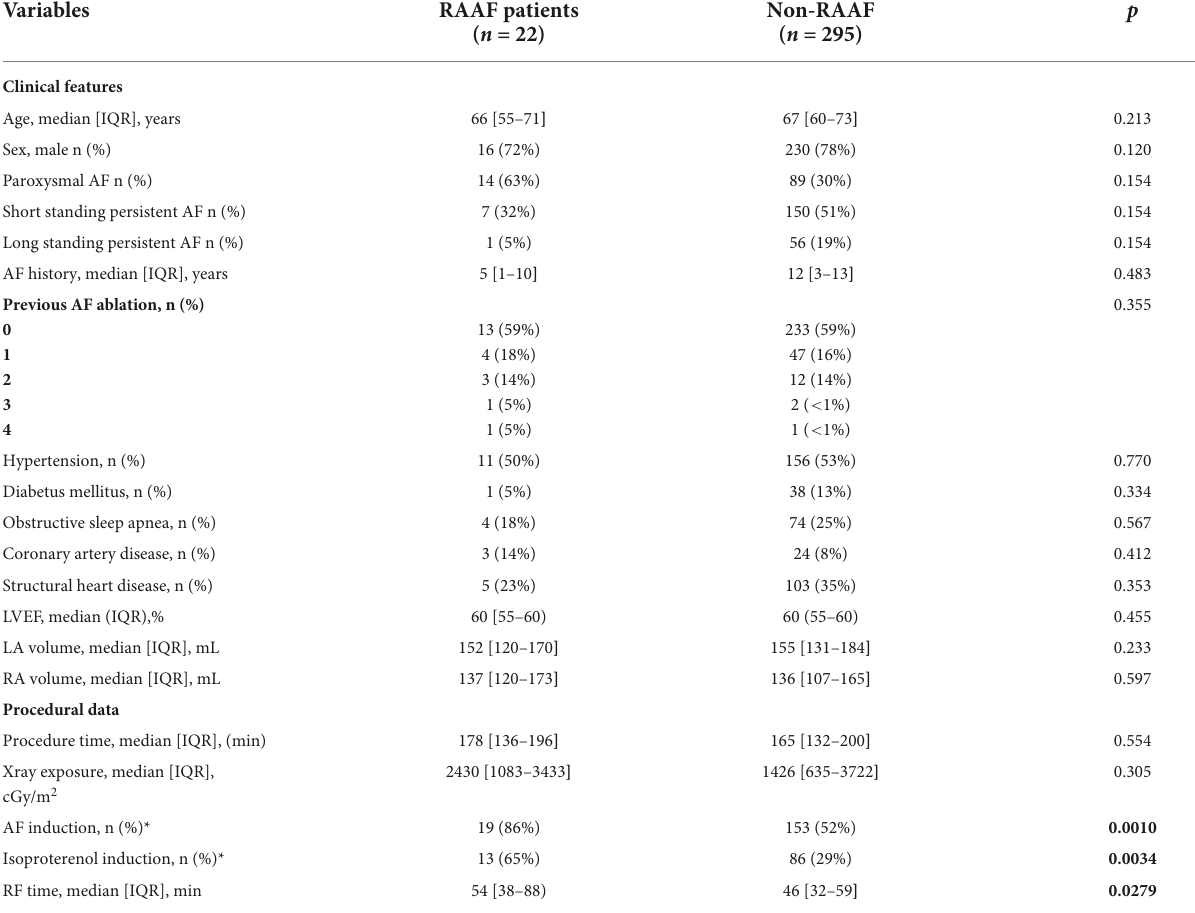
TABLE 1 Right atrial appendage firing (RAAF) and non-RAAF patients baseline characteristics.